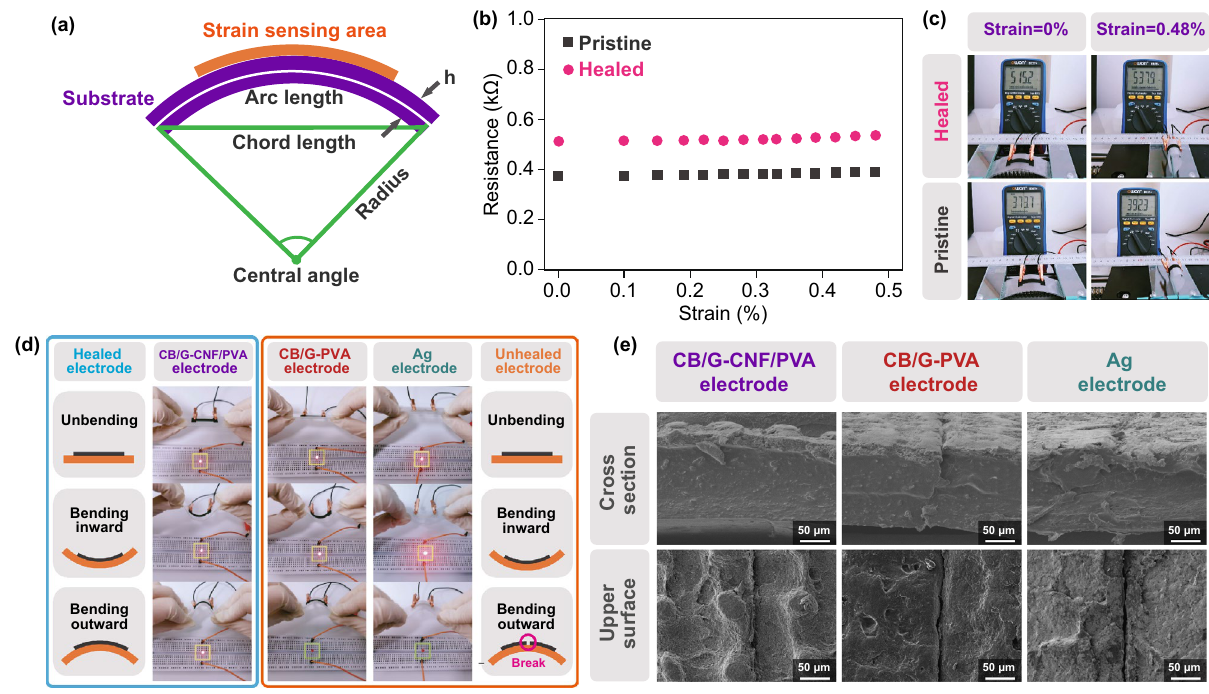
Fig. 2 a Schematic illustration of calculation model of strain. b Resistance of pristine and self-healed electrodes under various strains and c under strain of 0% and 0.48% measured by a digital multimeter. d Visual controlling by using CB/G-CNF/PVA electrodes, CB/G-PVA elec- trodes and commercial silver electrodes. The different brightnesses of LEDs indicate bending states. e SEM images of self-healed position of CB/G-CNF/PVA electrodes, CB/G-PVA electrodes and silver